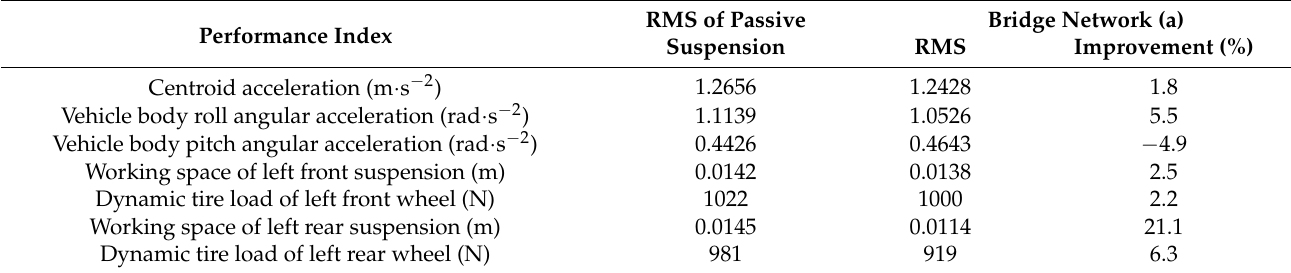
Table 6. Performance index with a random input.